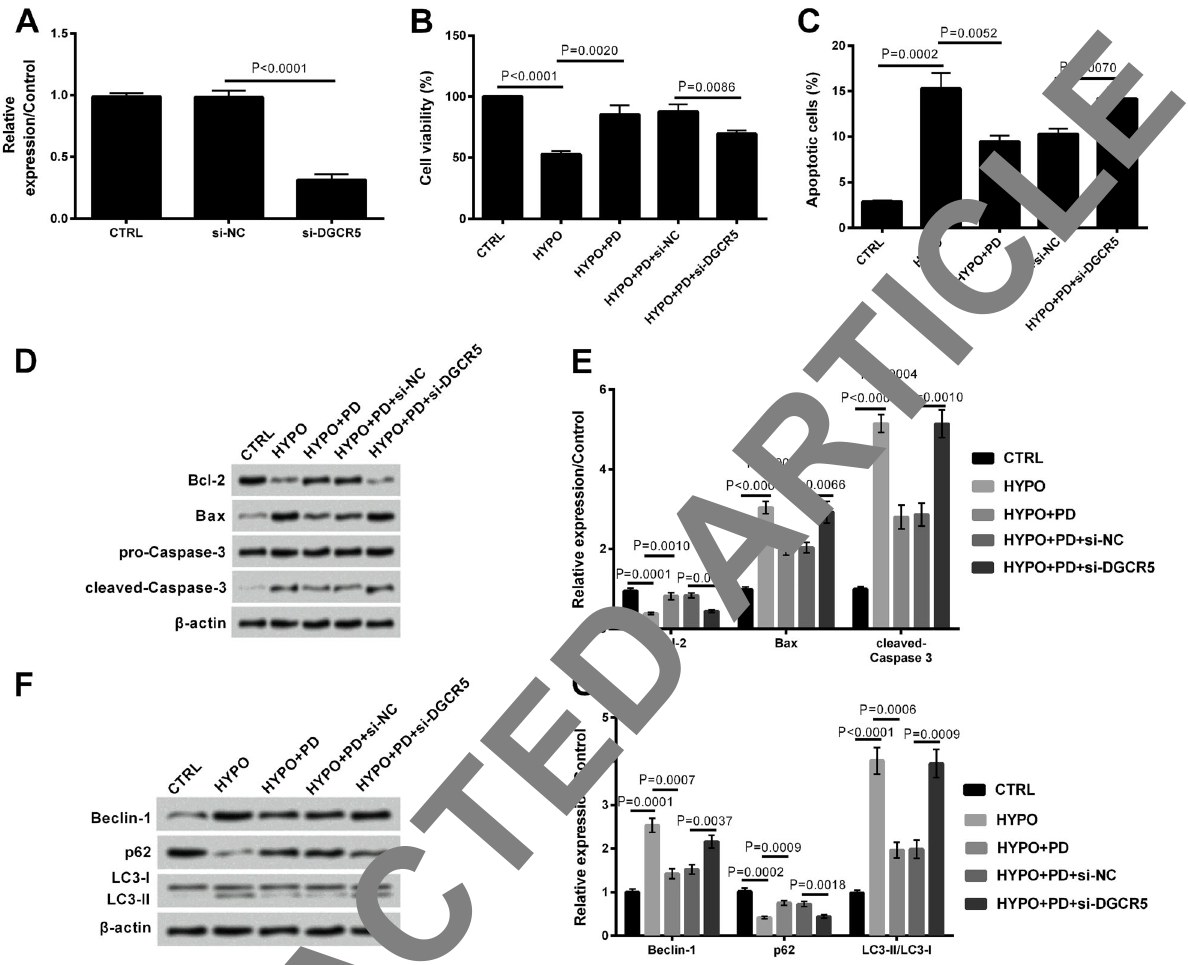
Figure 4. Polydatin (PD) reduced hypoxia-induced (HYPO) injury by up-regulating the expression of DGCR5. A , The expression level of DGCR5 was detected by qRT-PCR. B , Cell viability was measured by CCK-8 assay. C , Apoptosis of H9c2 cells was measured by fl ow cytometry. D and E , Western blot analysis was used to measure the expression levels of Bcl-2, Bax, and cleaved-caspase-3. F and G , Western blot analysis was used to determine the expression levels of Beclin-1, p62, LC3-II, and LC3-I. Data are reported as mean ± SD (ANOVA or Student ’ s t